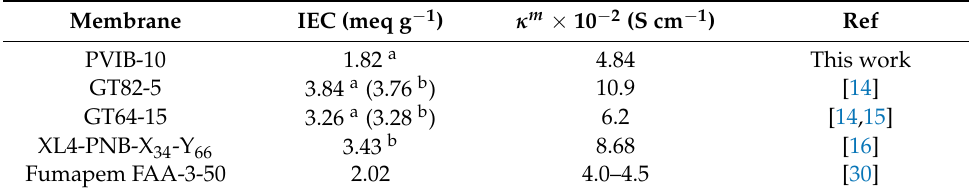
Table 2. Ion-exchange capacity (IEC) and hydroxide conductivity ( κ m ) values for PVIB, and a selection of anion-exchange membranes from papers referenced in this work. Membrane